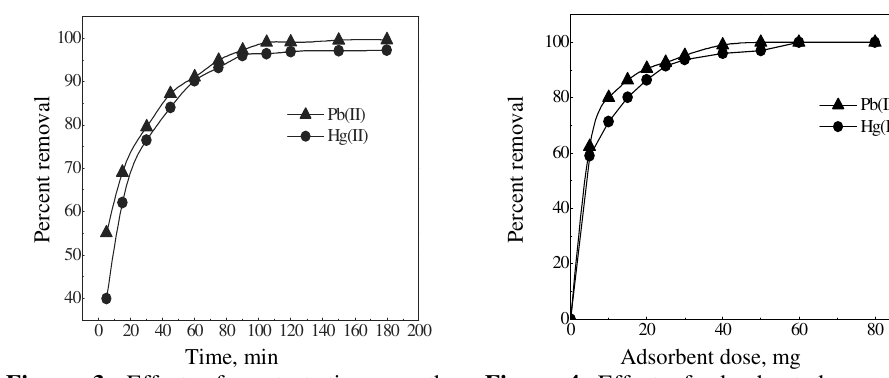
Figure 3. Effect of contact time on the removal of Pb(II) and Hg(II) ions on CSC (Initial Concentration- 10 mg L -1 )